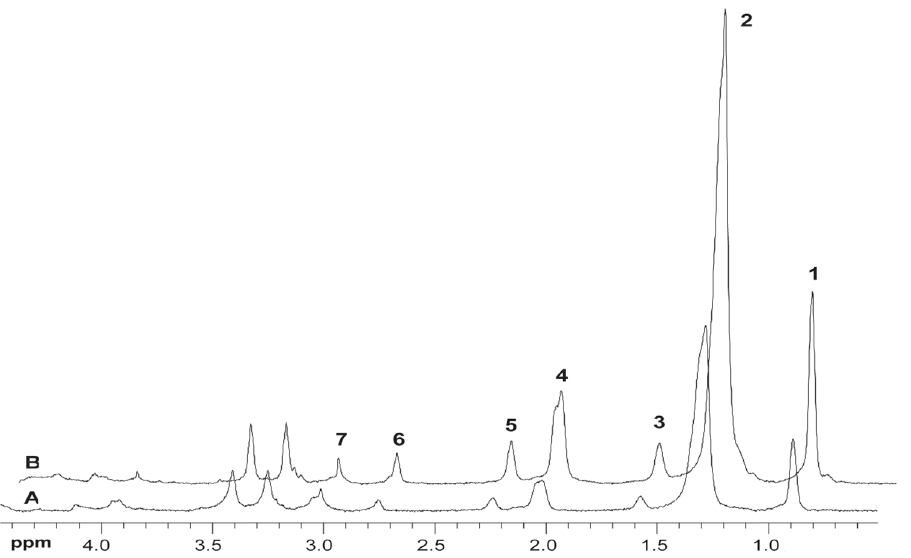
Figure 3. NMR spectra from 1 H-NMR HRMAS analysis of gastrocnemius skeletal muscle from 2-AA treated versus control mice. The spectra were acquired from 2-AA treated mice at 4 d versus control mice, and scaled to the phosphocreatine plus creatine peak (3.02 ppm). Resonance signals of lipids correspond to: 1) terminal methyl CH 3 protons (0.9 ppm); 2) acyl chain methylene protons (CH 2 ) n of intramyocellular lipids (IMCLs) (1.3 ppm); 3) methylene protons CH 2 C-CO (1.6 ppm); 4) allylic methylene protons C=C-CH 2 -C of monounsaturated fatty acyl moieties (MUFAs) (2.05 ppm); 5) a methylene protons CH 2 CO (2.25 ppm); 6) diallylic methylene protons =C-CH 2 -C= of polyunsaturated fatty acyl moieties (PUFAs); and 7) N-methyl protons of phosphocreatine and creatine (3.0 ppm), respectively. The NMR spectra demonstrate increased biomarkers of insulin resistance IMCLs.